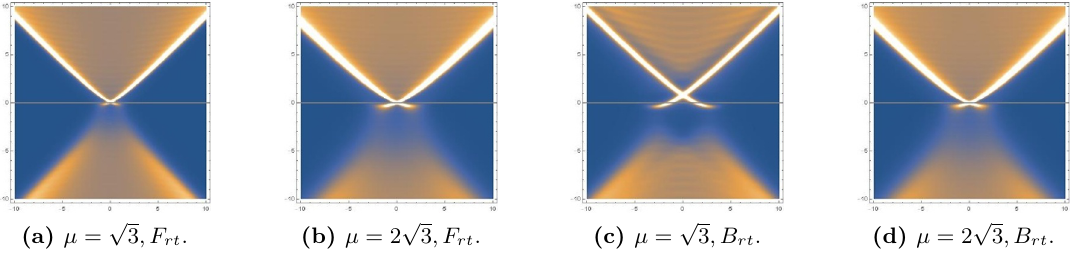
Figure 19. (a,b): SF for F rt and (c,d): SF for B rt with condensation B (0)